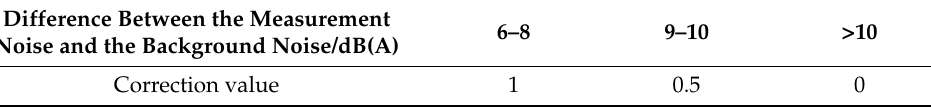
Table 7. Background noise correction value.